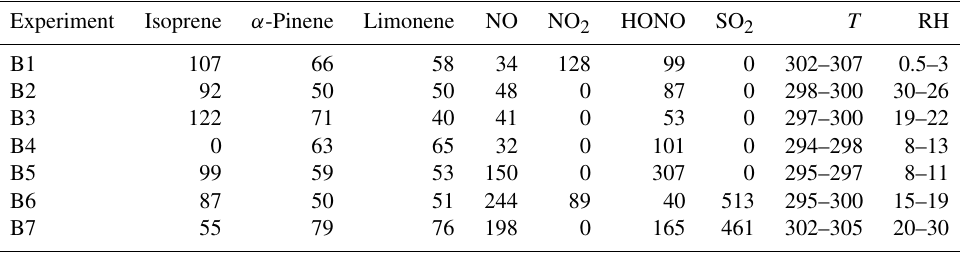
Table A2. Initial condition for biogenic VOC experiments from Couvidat et al. (2018). Concentrations in ppb, temperature ( T ) in Kelvin and relative humidity in